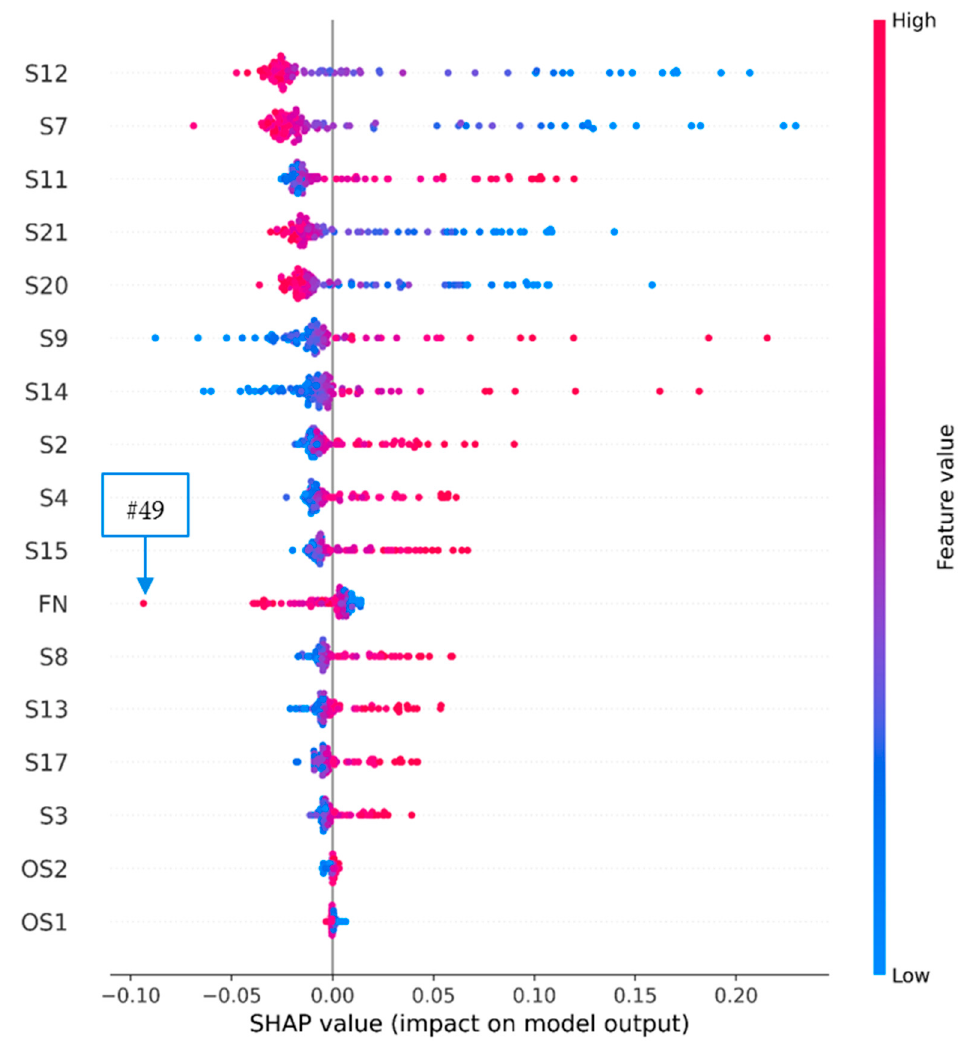
Figure 11. Dependence of the contribution of unique feature values to the forecast on their magnitude (indicated by the blue–red gradient).